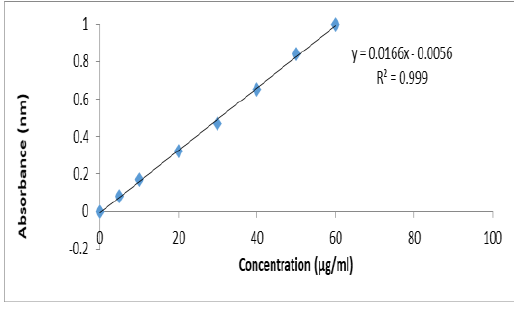
Figure 7. Tacrolimus UV calibration curve in 0.1 N HCL.